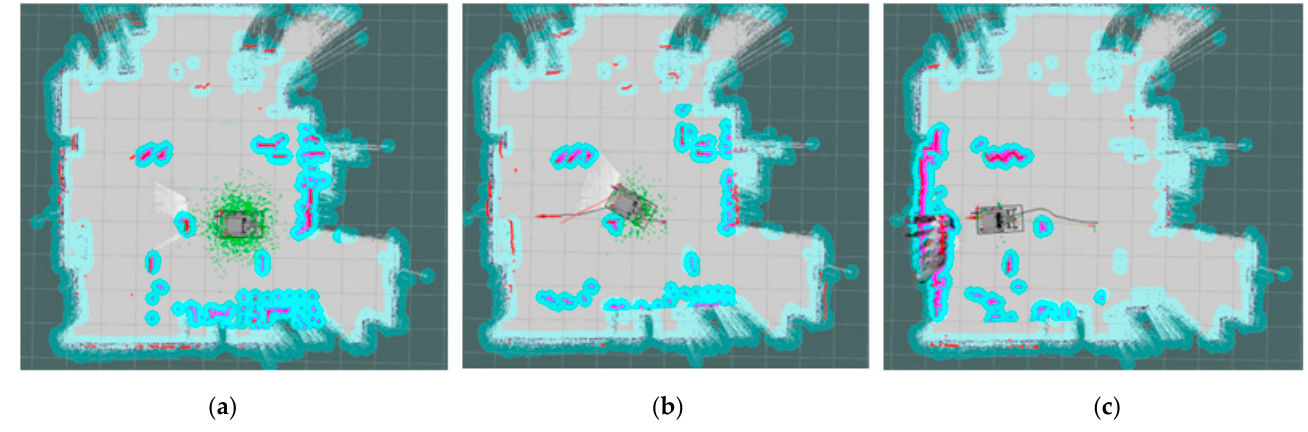
Figure 8. Map and path generated by applying the navigation system to the actual wheelchair robot. ( a ) The obstacles not found in the existing map, ( b ) creation of a new map, and ( c ) generation of a new path in real time to arrive at the